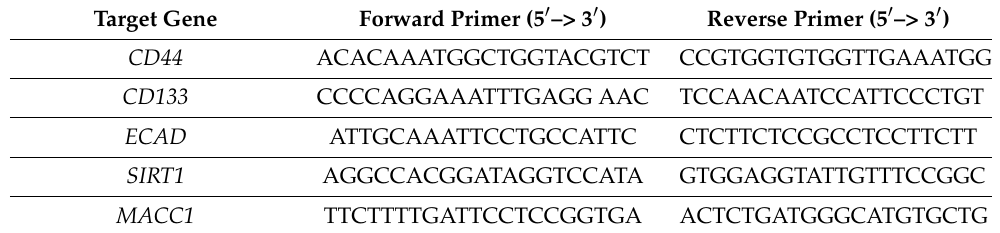
Table 3. List and sequence of all primers designed in-house which were used for RT-qPCR